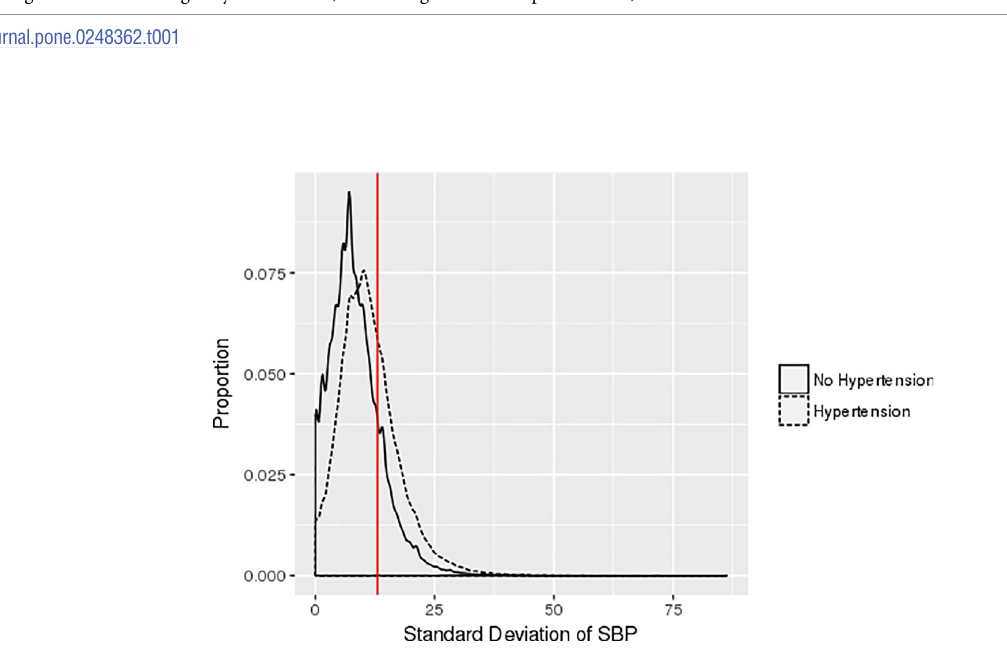
P value for High BPV vs.